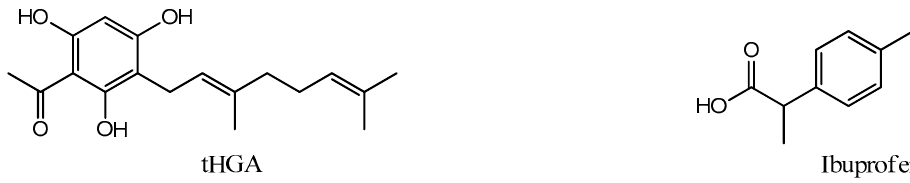
Figure 4. The chemical structures of 2,4,6-trihydroxy-3-geranylacetophenone (tHGA) and the internal standard, ibuprofen.